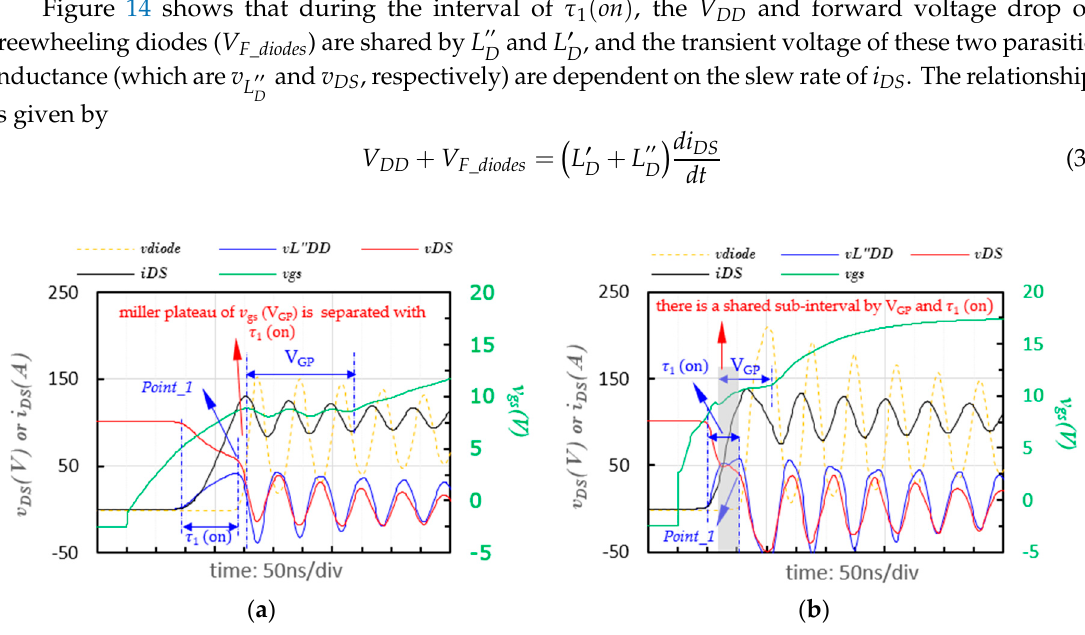
Figure 13. The simulation results about voltage plateau of 𝑣 (cid:3005)(cid:3020) for module_D by LTspice : ( a ) influence of 𝑉 (cid:3005)(cid:3005) , ( b ) influence of turn-on speed.